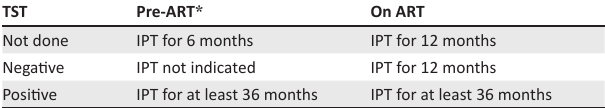
TABLE 15: Indications for and duration of isoniazid preventive